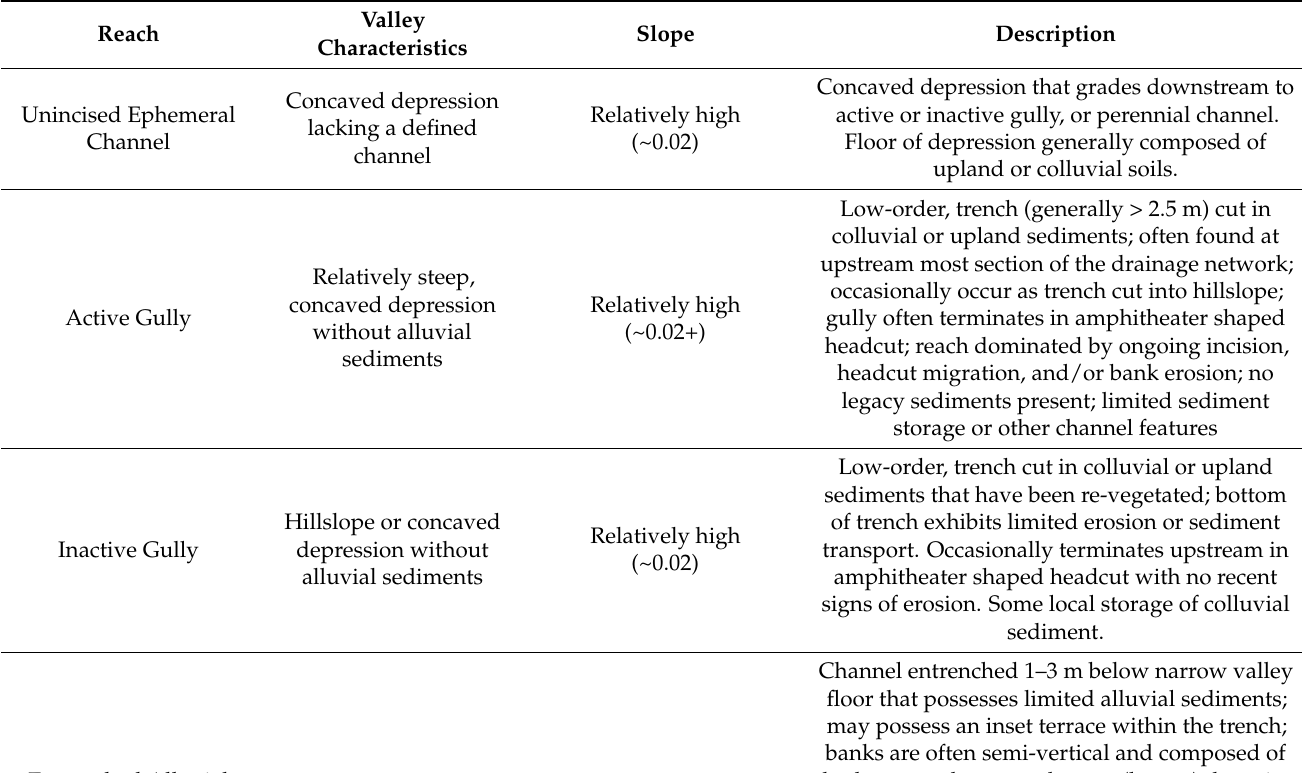
Table 1. Summary of process zone types and characteristics. See Figure 1 for spatial distribution of process